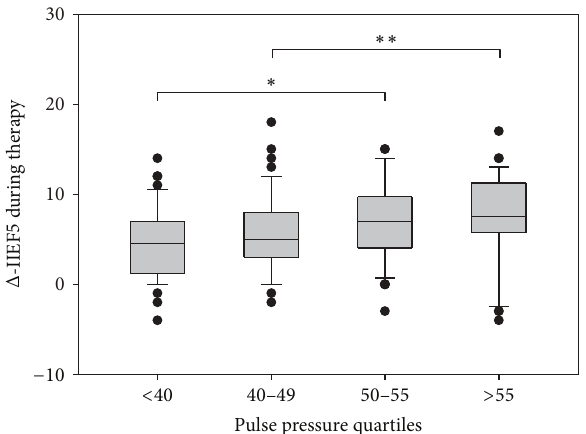
Figure 7: Change in IIEF-5 score in the population stratified according to quartiles of pulse pressure.